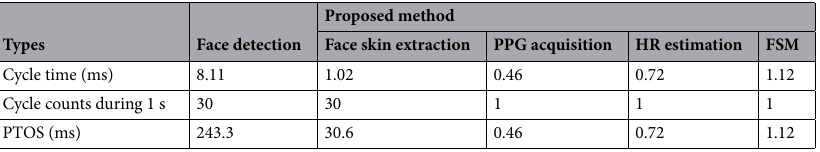
Table 5. Computation time for each stage of the proposed method with the FSM